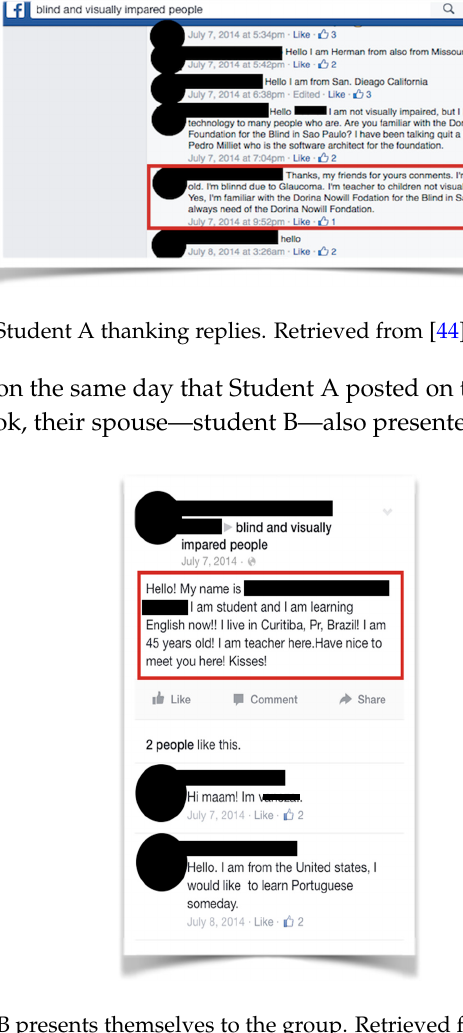
Figure 4. Student B presents themselves to the group. Retrieved from [44] with